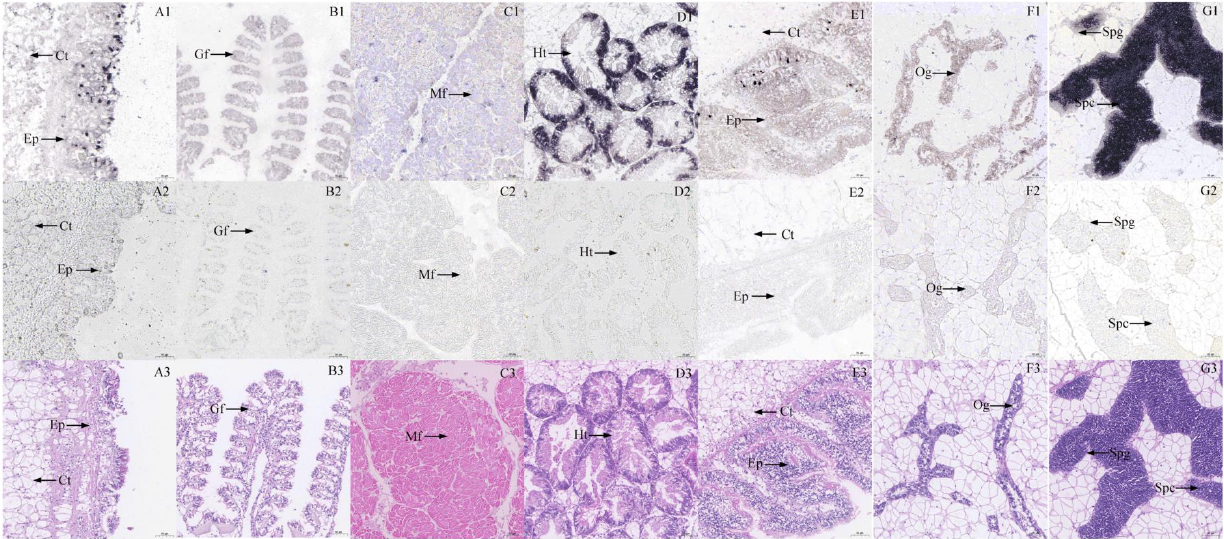
Figure 2. The distribution of GYS in the mantle ( A1 – A3 ), gill ( B1 – B3 ), adductor muscle ( C1 – C3 ), hepatopancreas ( D1 – D3 ), labial palp ( E1 – E3 ), ovary ( F1 – F3 ), and testis ( G1 – G3 ) of C. ariakensis at the proliferative stages. A1, B1, C3, D1, E1: GYS probe; A2, B2, C2, D2, E2: negative control; A3, B3, C3, D3, E1: hematoxylin – eosin staining. Ct: conjunctive tissues; Ep: epithelium; Gf: gill filament; Mf: muscle fiber; Ht: hepatic tubule; Og: oogonia; Spg: spermatogonia; Spc: spermatocyte.